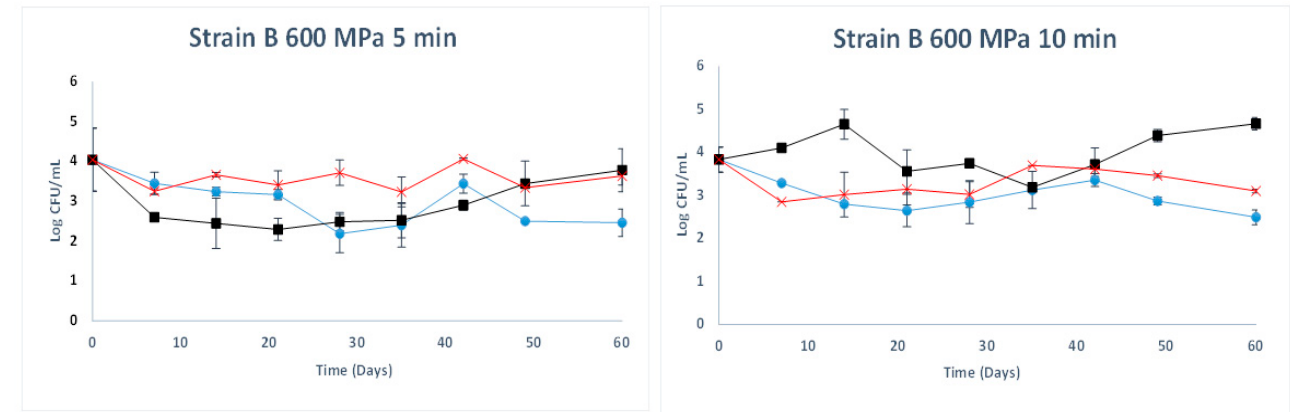
Figure 2. Survival curves of A. acidoterrestris (Strain B) spores treated at 600 MPa/60 °C for 5 and 10 min and stored at 4 °C ( ● ), 12 °C ( ■ ) and 25 °C (x). Data points are mean values ± standard devia- tion of duplicate samples from two independent experiments ( n = 4).